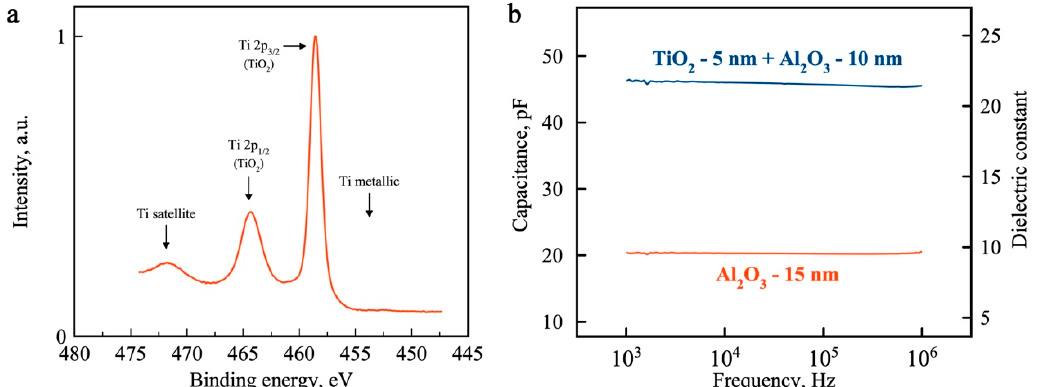
Figure 3. Chemical composition and dielectric properties. ( a ) XPS spectra of titanium layer oxidized in air for 24 h, confirming complete oxidation of the seed layer; ( b ) dielectric constant of pure ALD thin film (15 nm Al 2 O 3 , red curve) and compound dielectric (5 nm TiO 2 + 10 nm Al 2 O 3 , blue curve) and their frequency response.